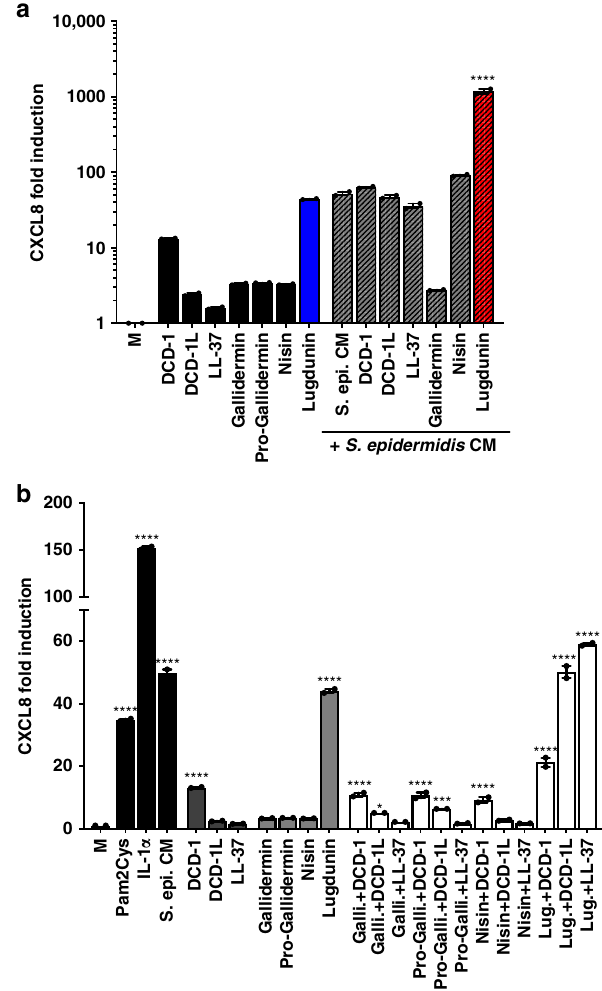
Fig. 4 Lugdunin ampli fi es the commensal-induced chemokine (C-X-C motif) ligand (CXCL8) induction. a Primary human keratinocytes (PHKs) were either treated with 2 μ M of human antimicrobial peptides (AMPs) (black bars) or lugdunin (blue bars), or 0.8 μ M (pro)-gallidermin or nisin (black bars), or in combination with S. epidermidis conditioned medium (CM) (gray and red striped bars) for 5 h, and subsequently expression of CXCL8 was analyzed and normalized to actin. Shown is one representative experiment of three independent experiments with two technical replicates ± s.e.m. b PHKs were treated with 2 μ M human AMPs, 2 μ M lugdunin, 0.8 μ M of the other bacteriocins (gray bars) or the correspondent peptide combinations (white bars), or 50 ng/mL Pam2Cys, 10 ng/mL IL-1 α , or S. epidermidis CM as controls (black bars), for 5 h and subsequently expression of CXCL8 was analyzed and normalized to actin. Shown is one